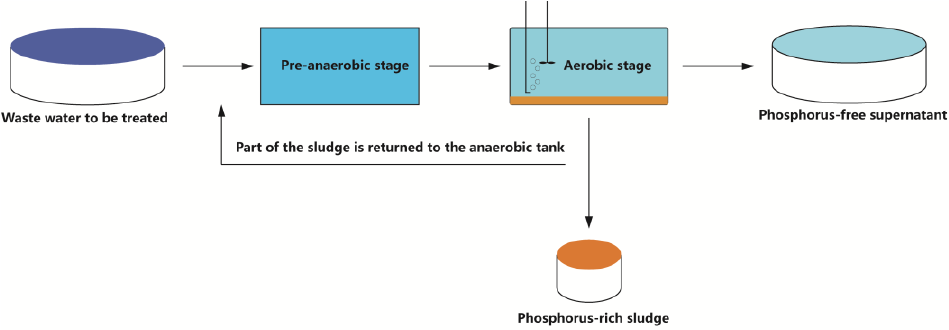
Figure 1. Diagram of traditional EBPR phosphorus removal method.